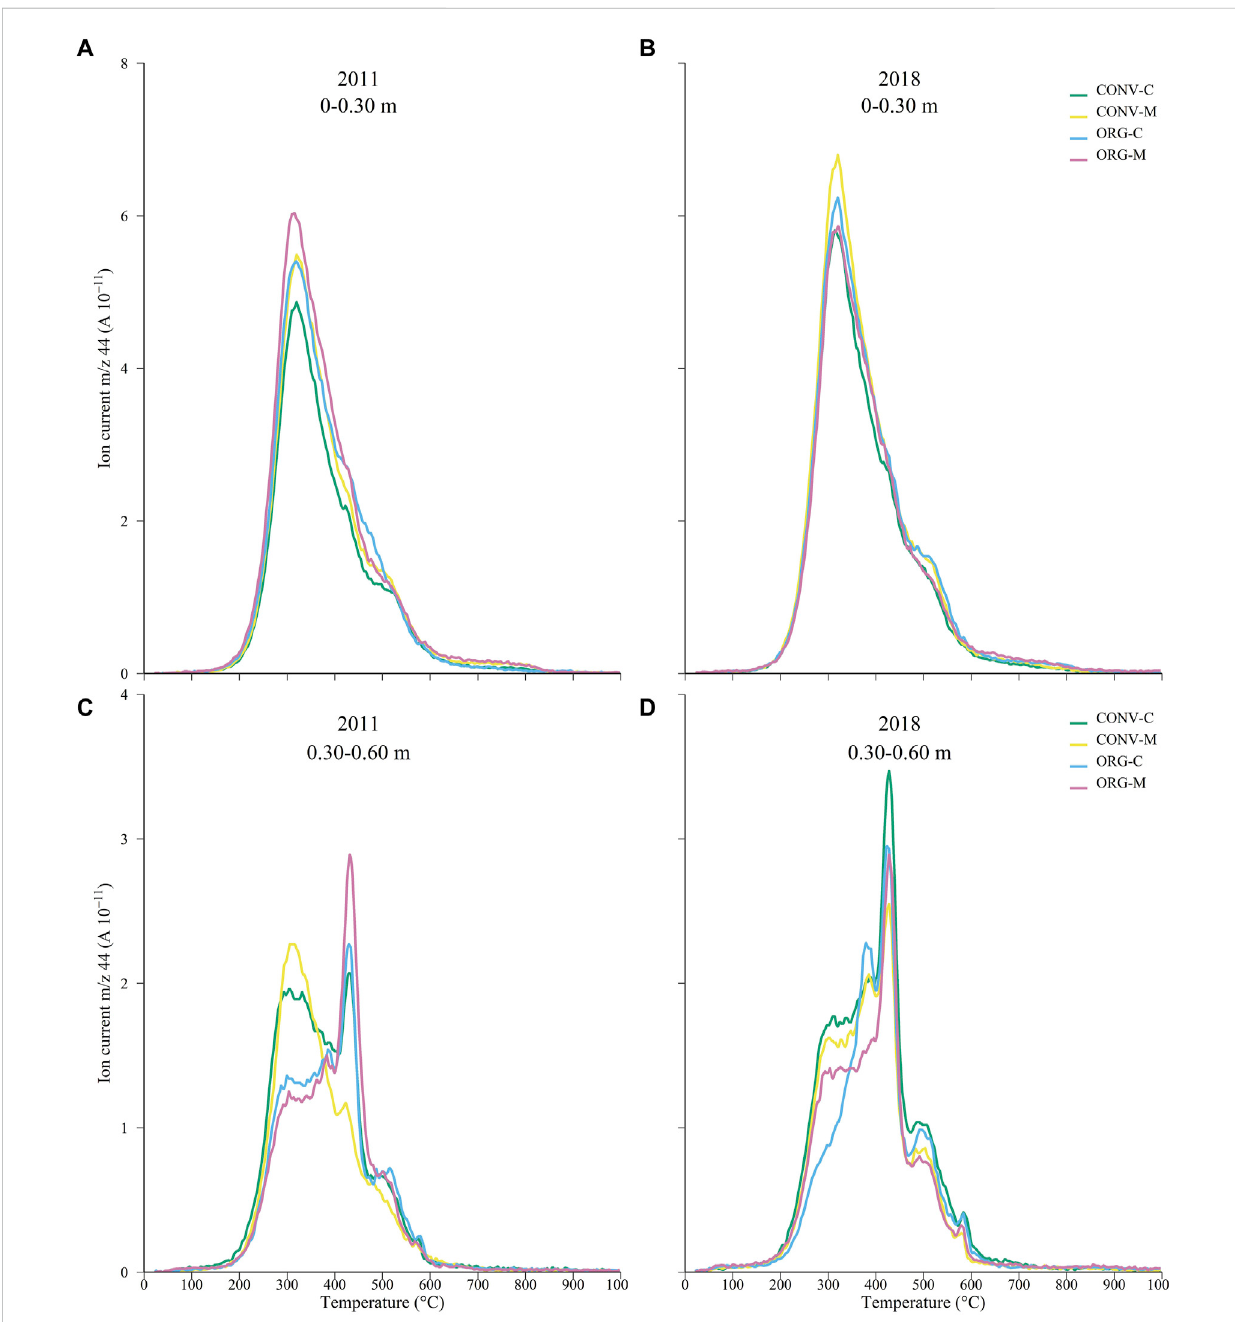
FIGURE 4 Ion current intensity for CO 2 ( m/z 44) from the soil samples of combined treatment factors: conventional rotation with mineral fertilisation (CONV-M), conventional rotation with compost fertilisation (CONV-C), organic rotation with mineral fertilisation (ORG-M) and organic rotation with compost fertilisation (ORG-C) at 0 – 0.30 (A, B) and 0.30 – 0.60 m (C, D) soil depth intervals and different years of sampling 2011 (A, C) and 2018 (B, D)